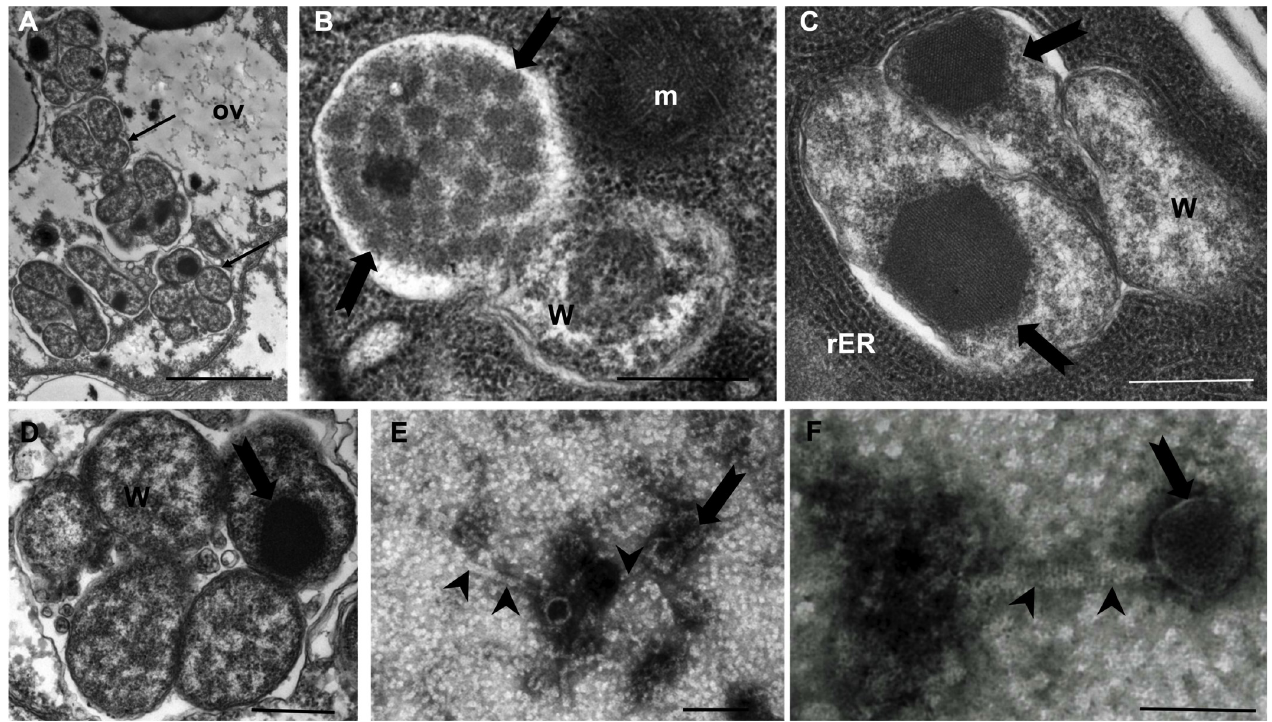
Fig 2. Transmission electron microscopy (TEM) of WOSoc particles. A. Clusters of intracellular Wolbachia w Soc (arrows) in the ovary of A . socius (scale bar 2 μ m ) . B. Densely packed WOSoc phage (arrows) inside a Wolbachia endobacterium (scale bar 500 nm). C. and D. Compact, electron dense hexagonal arrays of WOSoc (arrows) in Wolbachia (scale bar 500 nm ) . E. and F. Complete, purified phage particles with 47 to 62 nm capsids (arrow) and 175 to 130 nm tails (arrow head, scale bar 100 nm). Abbreviations: ov, ovaries; W, Wolbachia , rER, rough endoplasmic reticulum; m, mitochondrion.